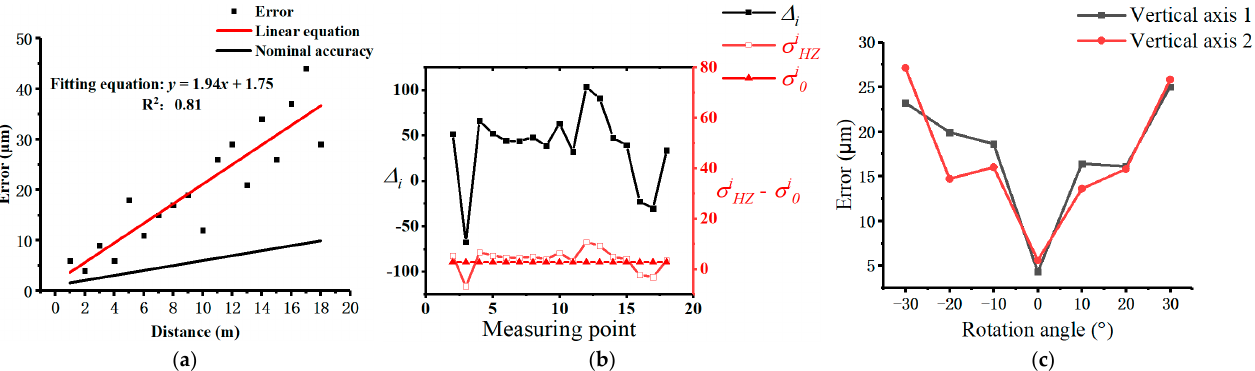
Figure 6. Error calibration results: ( a ) range measurement calibration, ( b ) angle measurement calibration, and ( c ) laser incident angle error calibration.